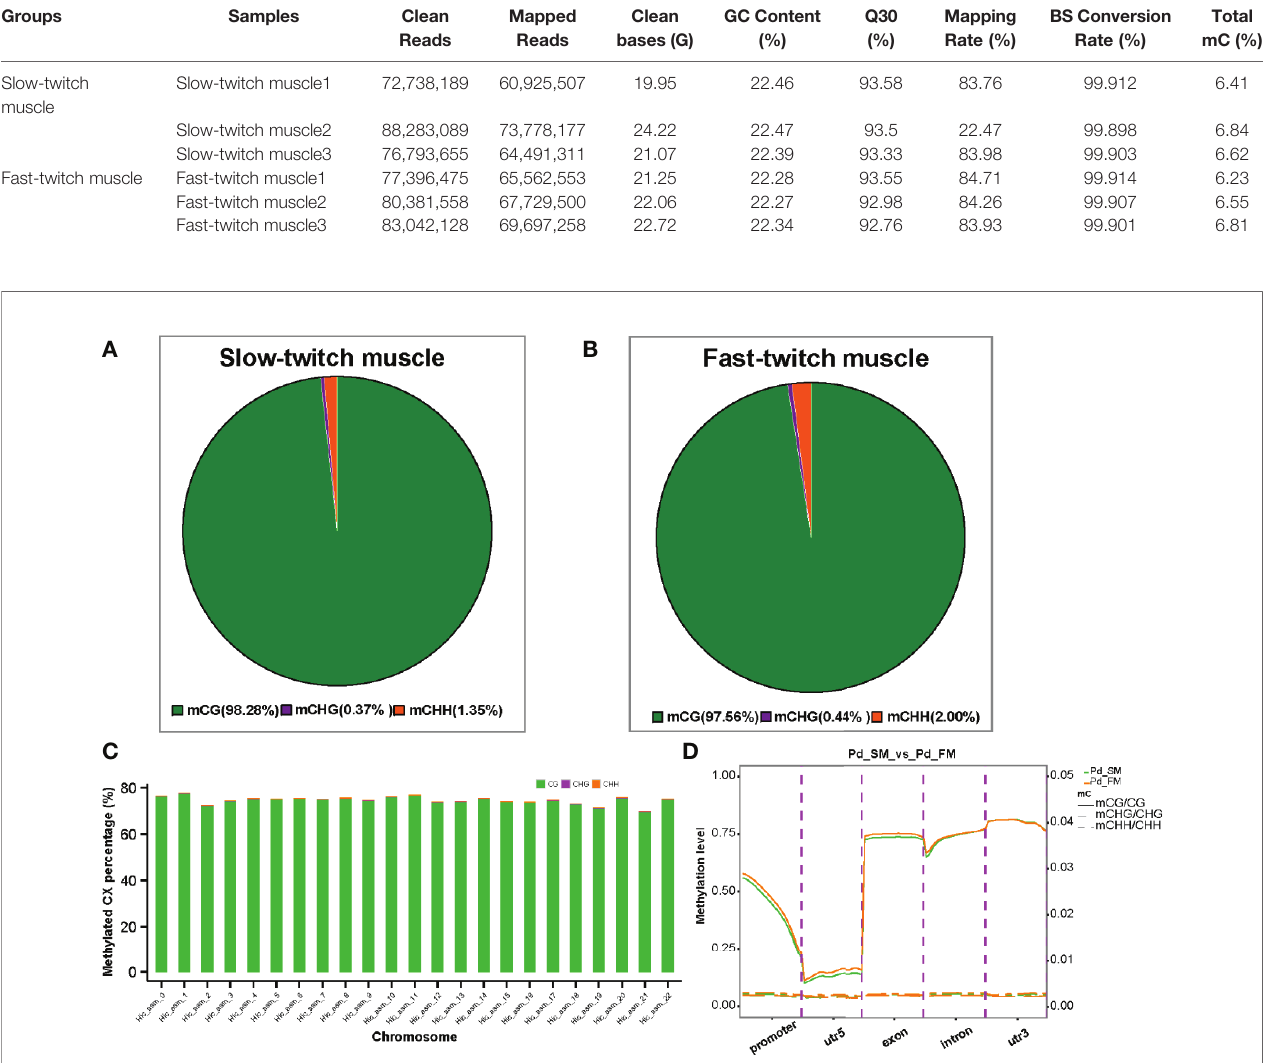
FIGURE 1 | The DNA methylation characteristics of slow-twitch muscles and fast-twitch muscles in P. dentex . The average ratio of DNA methylation types in slow- (A) and fast-twitch muscles (B) . The green, purple, and orange colors represent methylated CG, CHG, and CHH, respectively. (C) Representative image of methylation level distribution on each chromosome in P. dentex . The methylation level data of mCG/mCHH/mCHG on each chromosome in slow- and fast-twitch muscles could be got in Supplementary Table 2 . (D) DNA methylation levels in functional regions of the